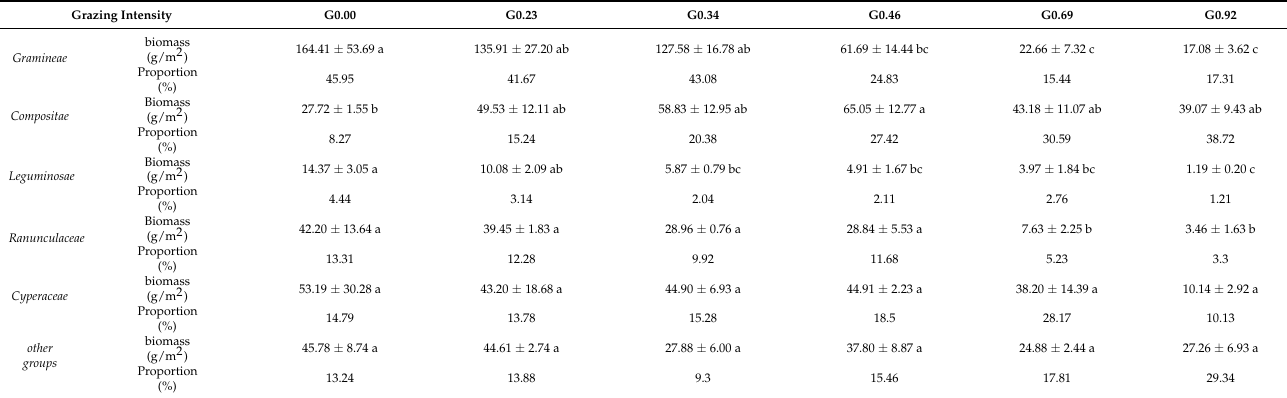
Table 2. Biomass and percentage of different functional